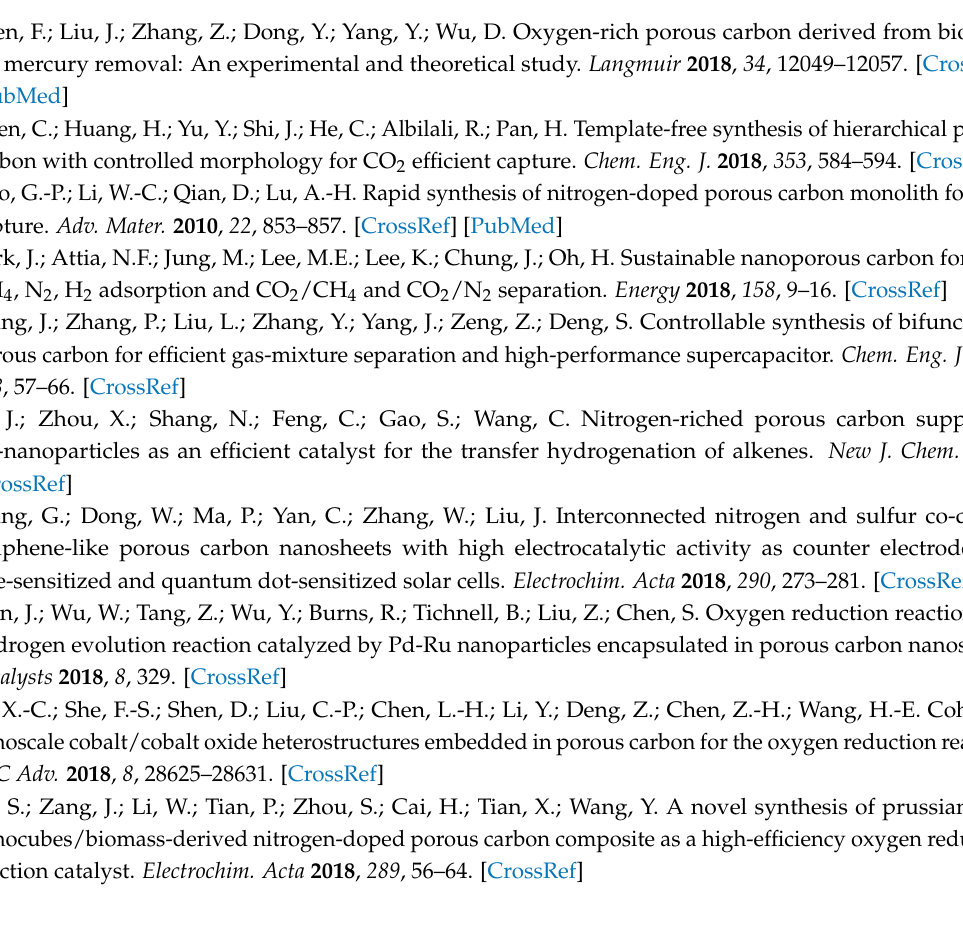
Figure S1: Compression-recovery elasticity of PC-5. (A) Initial state of PC-5, (B) Pressed with a 200g weight, (C) In recovery and (D) After the recovery, Figure S2: FT-IR spectra of glucose, Figure S3: FT-IR spectrum of dopamine, Figure S4: Scanning electron microscopy image of PC-5 (50 × ), Figure S5: Barrett-Joyner-Halenda (BJH) analysis of porous carbon, (A) PC-0, (B) PC-1, (C) PC-5, (D) PC-10, Figure S6: MP analysis of porous carbon, (A) PC-0, (B) PC-1, (C) PC-5, (D)